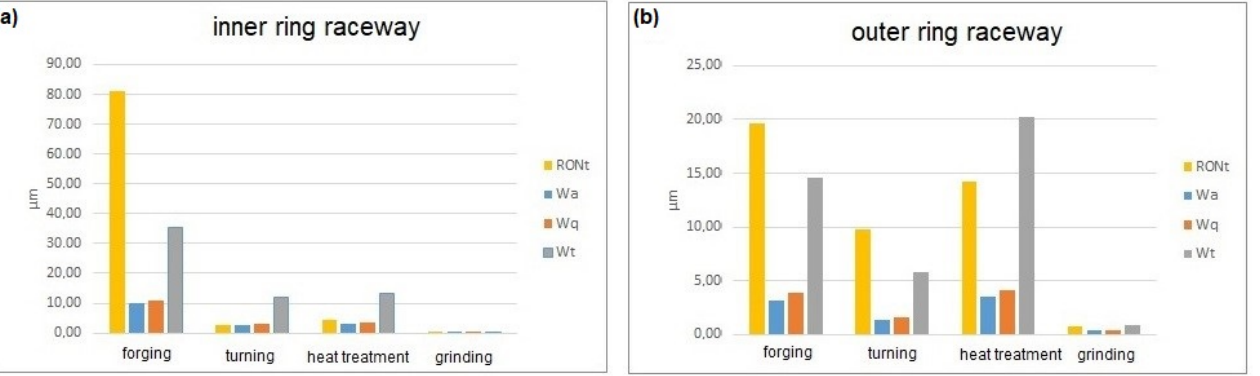
Figure 3. Results of the surface waviness measurements of the inner ( a ) and outer ( b ) races of the 6308-2z roller bearing rings.